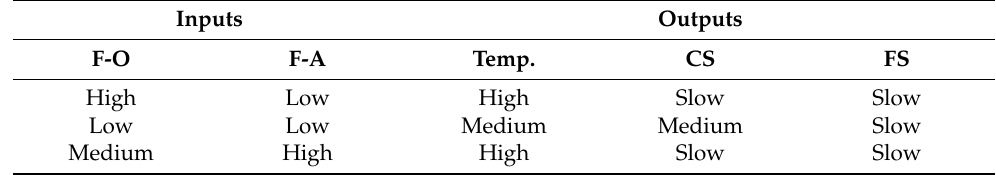
Table 4. Rules for falsity membership of neutrosophic logic represented as (F-O, F-A).